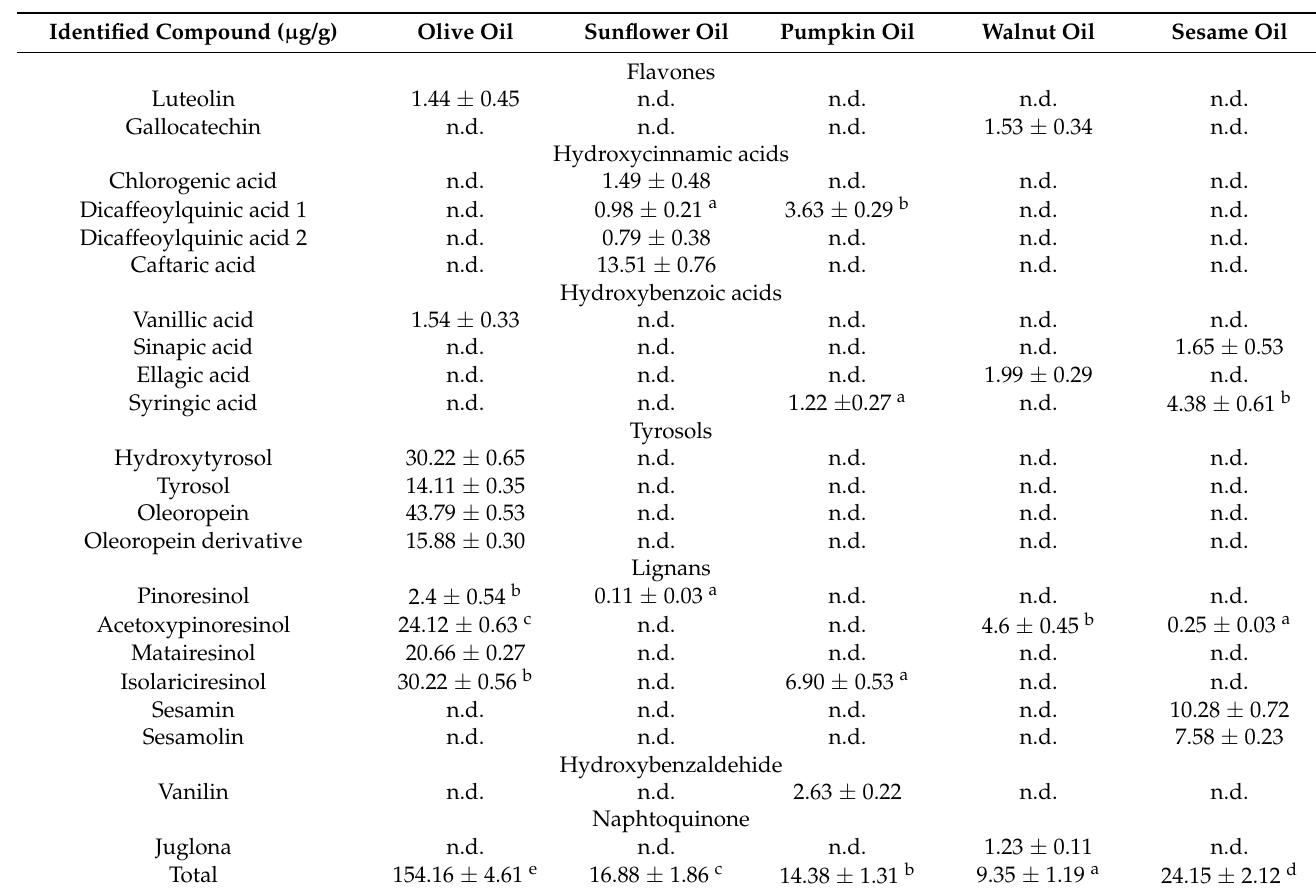
Table 5. Polyphenolic compounds identified in